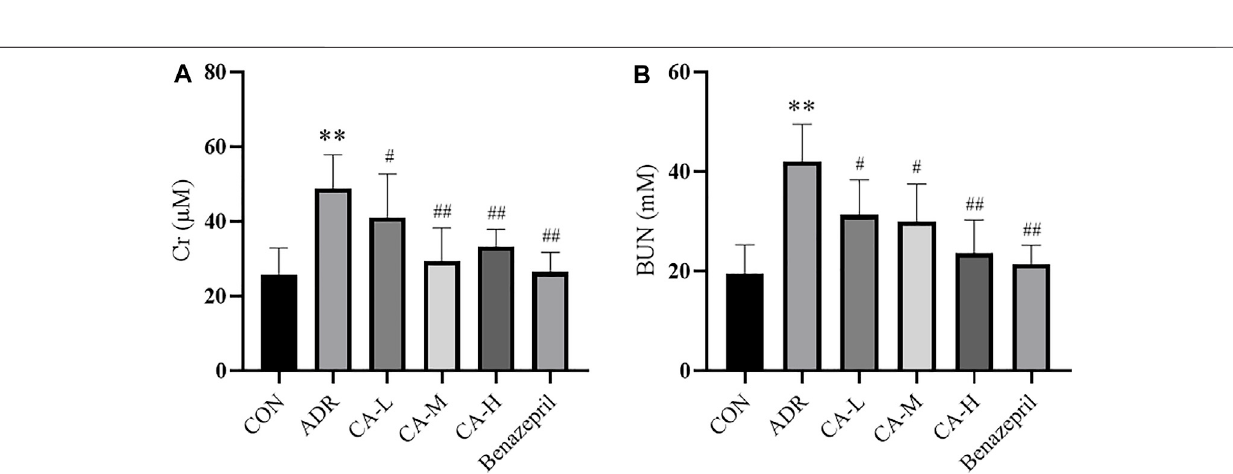
FIGURE 12 | The Cr (A) and BUN (B) in rats. ** p < 0.01 vs CON group; # p < 0.05, ## p < 0.01 vs ADR group.